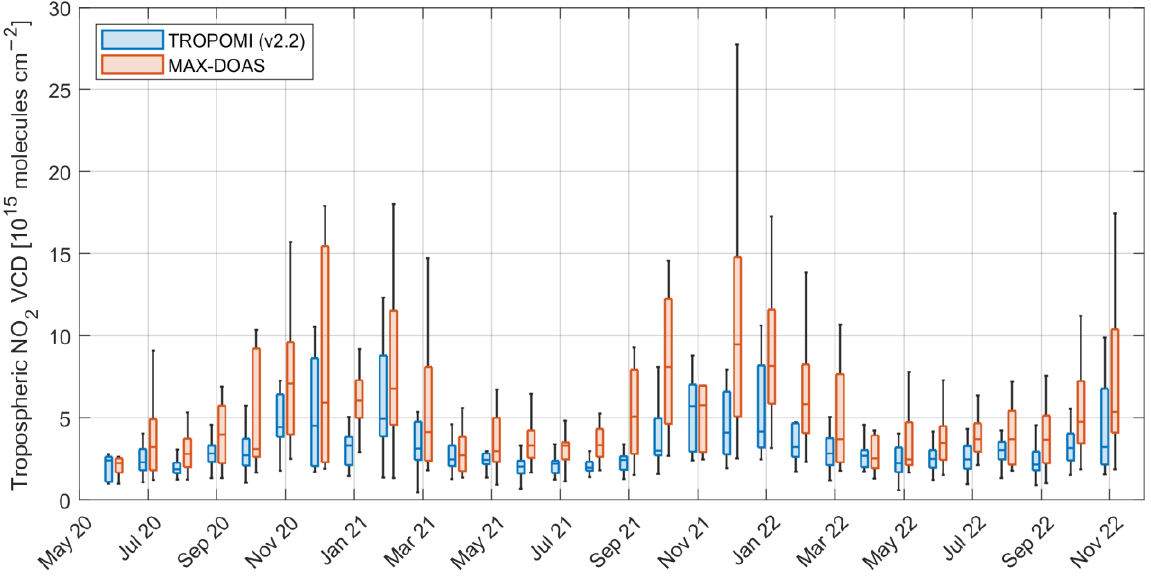
Figure 8. Time series of monthly mean tropospheric NO 2 vertical columns in Thessaloniki from collocated ground-based MAX-DOAS and S5P/TROPOMI observations for the period June 2020 – November 2022.